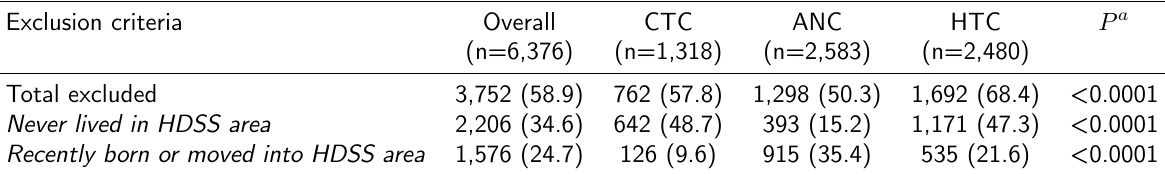
Table 1: Exclusion criteria among point-of-contact interactive record linkage (PIRL) participants in rural Tanzania by